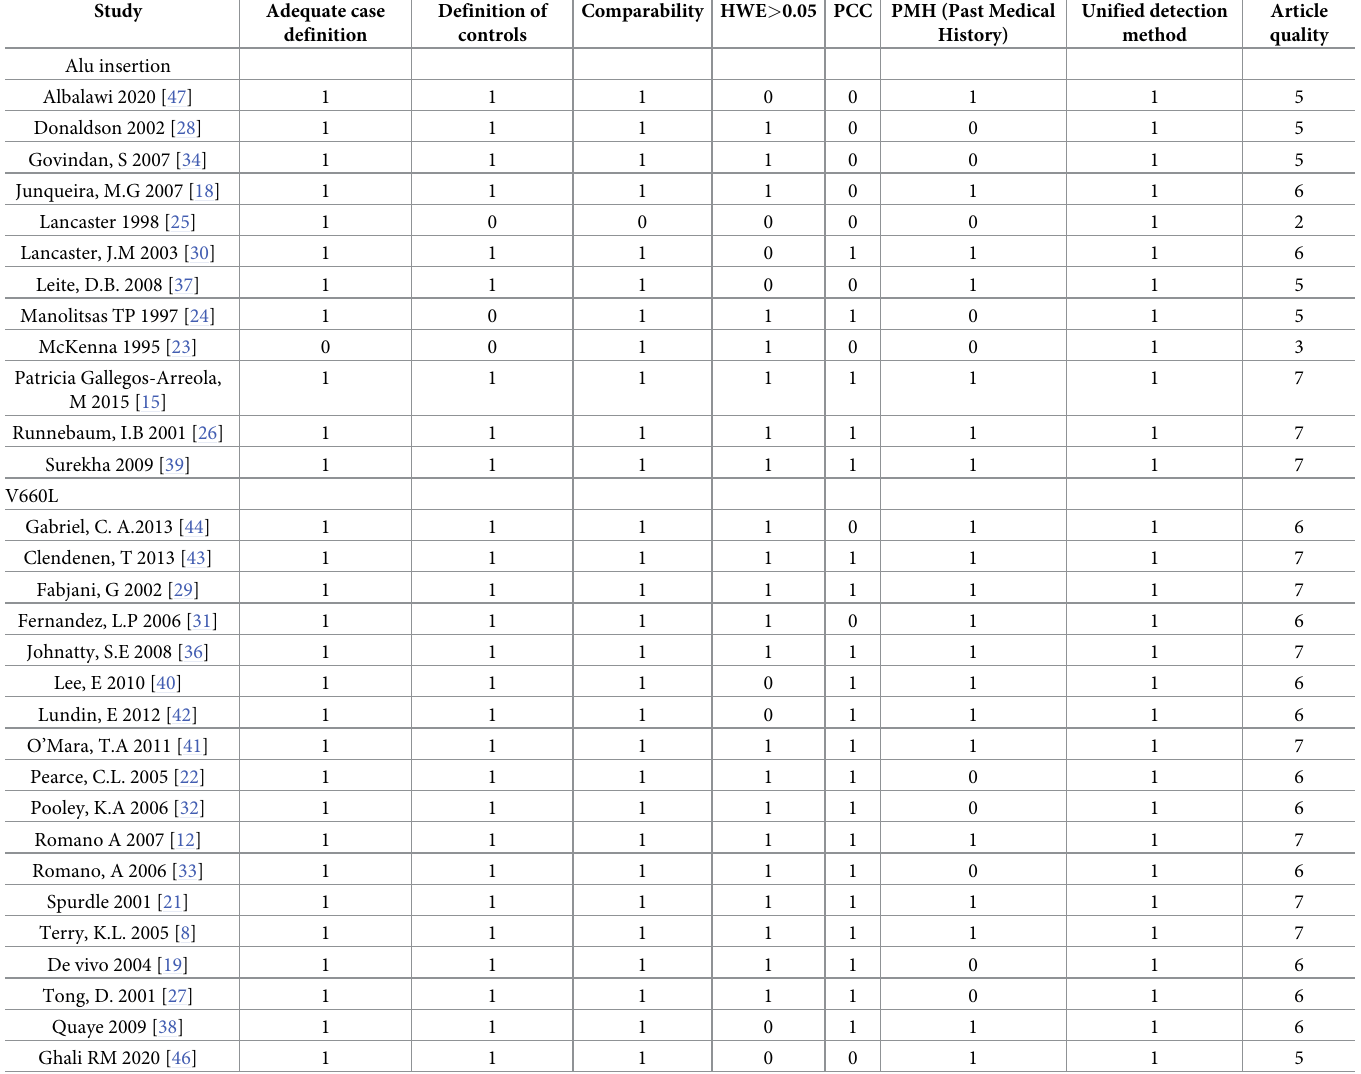
Table 2. Article quality